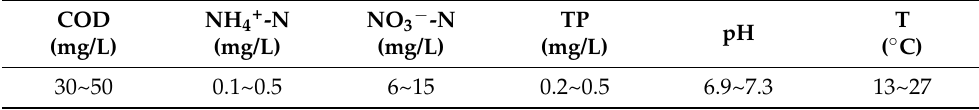
Table 1. Effluent quality of the secondary sedimentation